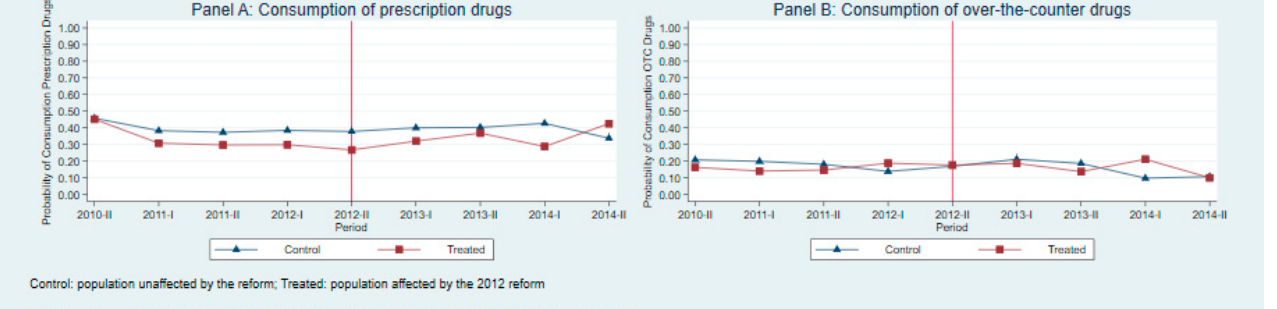
Figure 1. Common trends assumption graphical